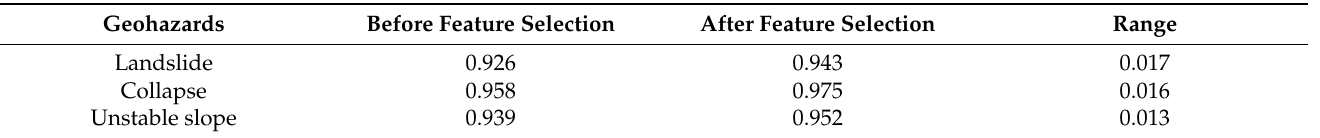
Table 9. Changes in AUC after using the filter-MDA feature selection method. As the models were rebuilt in every iteration, the model scores are not logged.